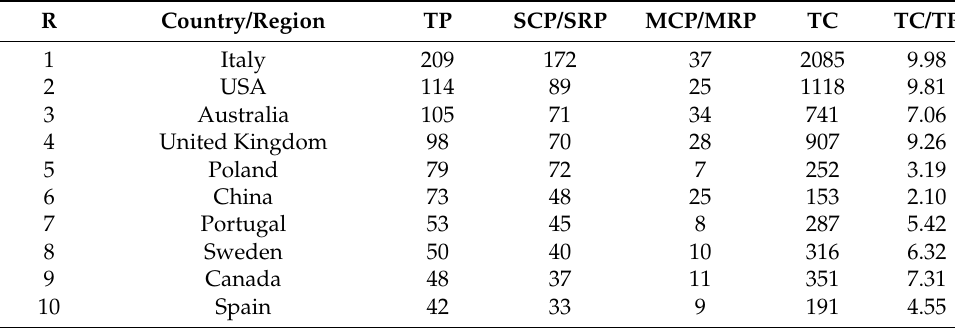
Table 6. Most productive